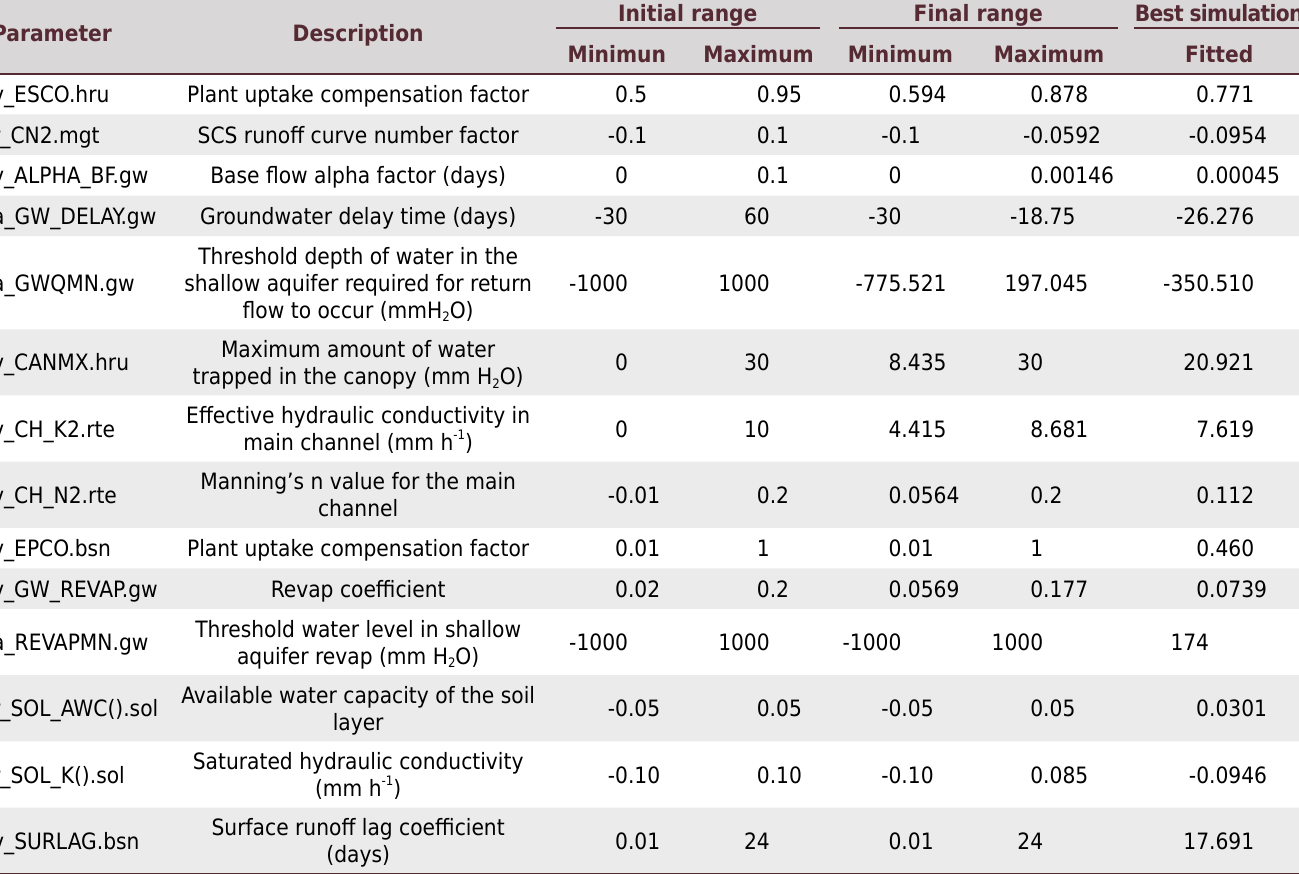
Table 2. List of parameters adjusted during the calibration process, their description, and results